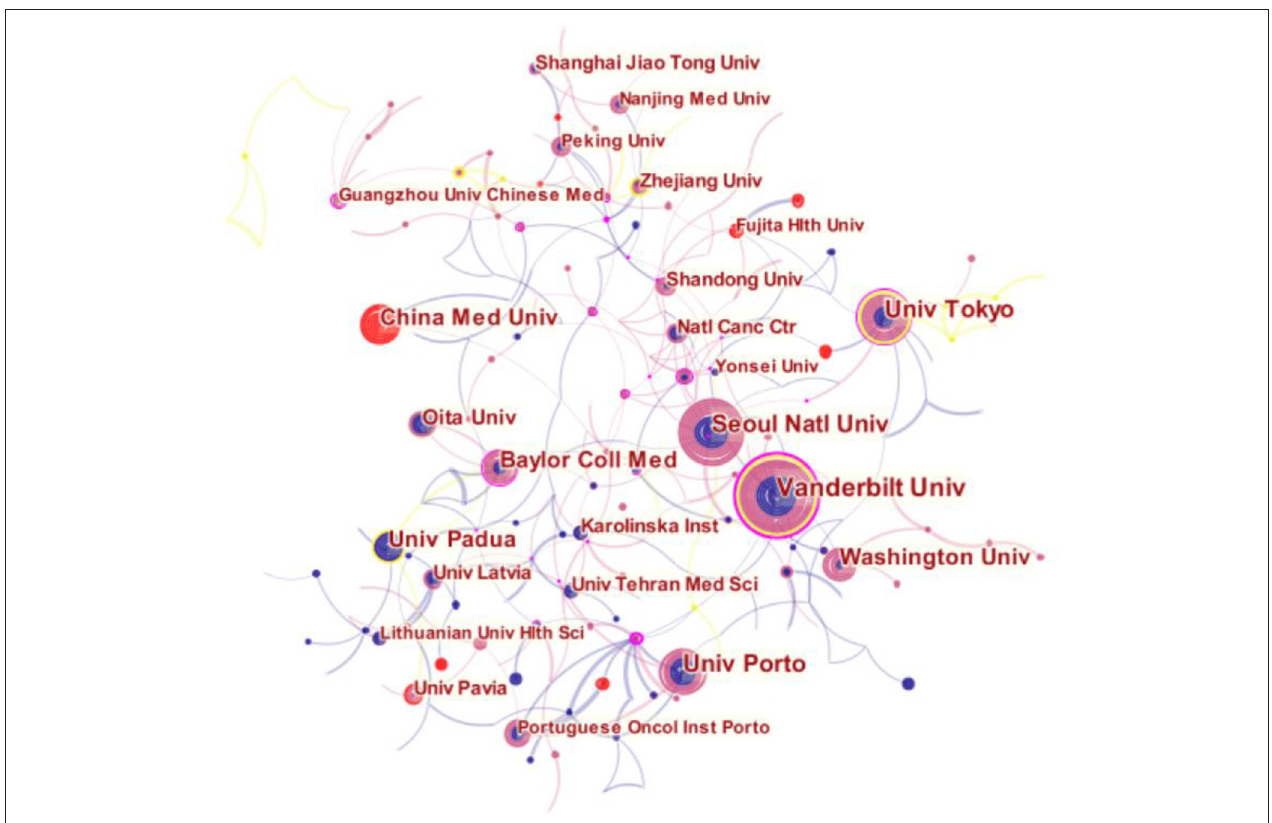
FIGURE 3 | Network of institutions engaged in AG research.